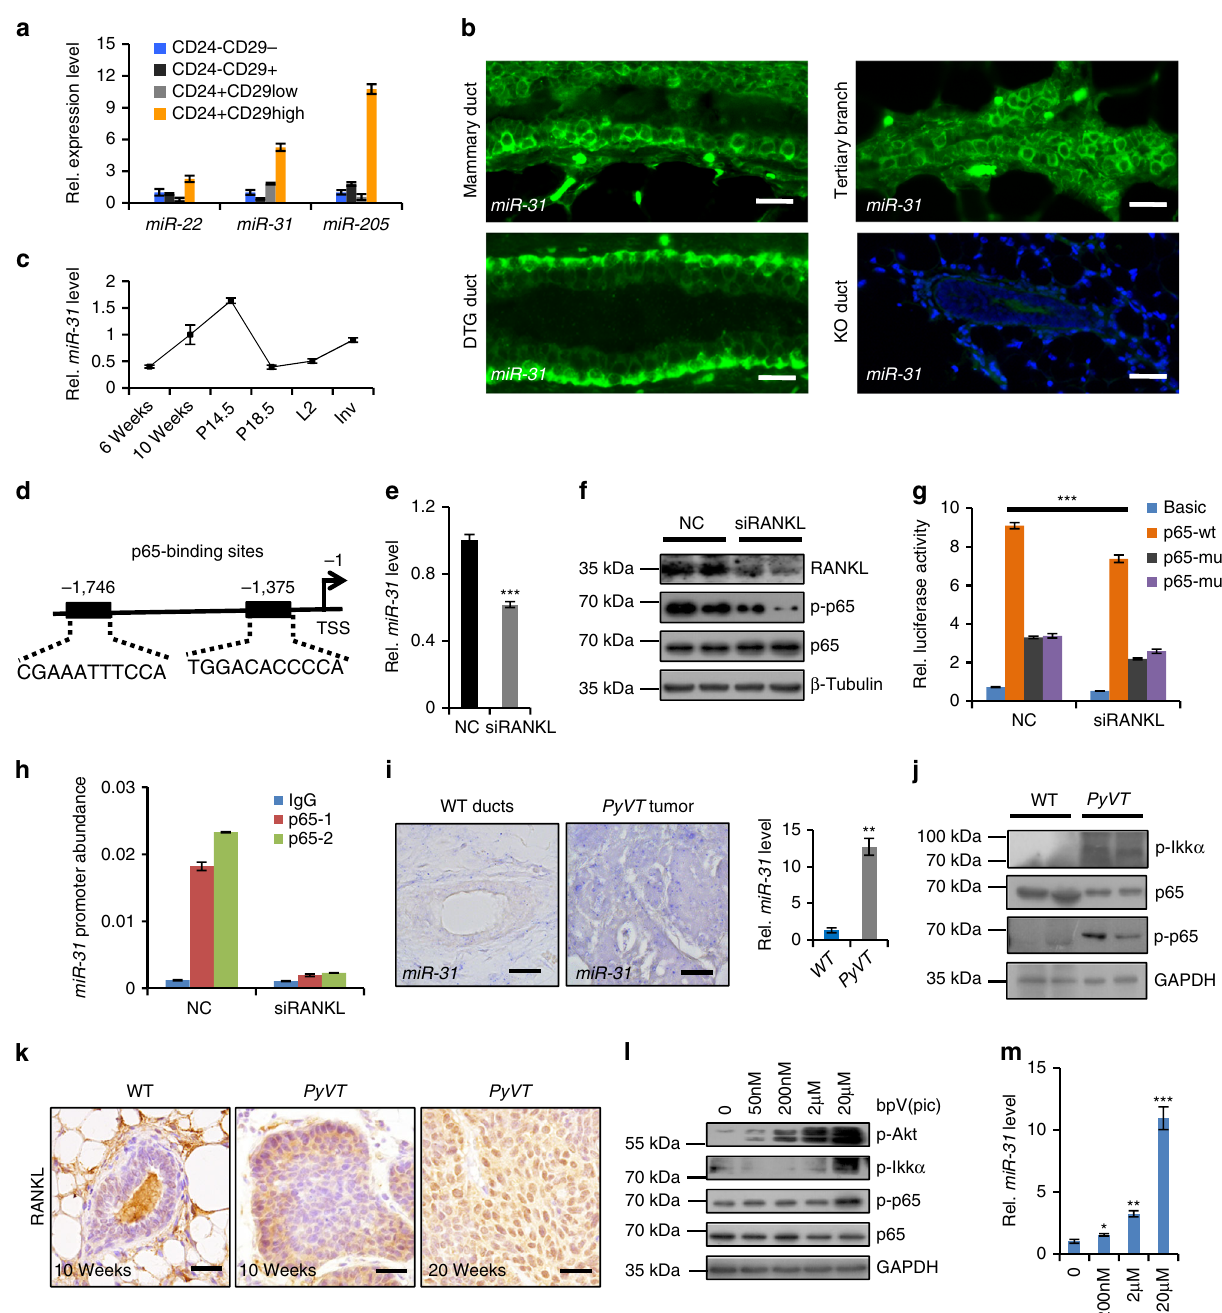
Fig. 1 Expression pattern of miR-31 in mammary gland and tumors. a qRT-PCR for miR-31 , miR-22 and miR205 in Lin - CD24 + CD29 high , Lin - CD24 + CD29 low , Lin - CD24 - CD29 + and Lin - CD24 - CD29 - populations at 12 weeks of age. n = 3 biological replicates. b In situ hybridization for miR-31 in 12-week-old WT mammary gland ducts and tertiary branches. DTG mammary ducts, a positive control. The DTG mice have been administered with Dox at 1 week of age. miR-31 KO mammary ducts, a negative control. Scale bar, 25 μ m. c qRT-PCR for miR-31 in WT mammary epithelial cells at 6, 10 weeks, P14.5 (14.5 days post pregnancy), P18.5, L1 (1 day post lactation) and Inv (10 days post involution). n = 3 at each time points. d The schematic diagram showing two potential p65 (NF- κ B) binding sites (-1746 bp and -1375 bp) in the miR-31 promoter. TSS, transcription start site. e , f qRT-PCR for miR-31 e and western blotting for RANKL, p-p65, p65 f in HC11 mouse mammary epithelial cells treated with RANKL siRNA (SiRANKL), and scramble RNA (NC). g Luciferase activity in lysates of HC11 mouse mammary epithelial cells transfected with luciferase reporter plasmids of pGL3-basic plasmid, miR-31 promoter or miR-31 mutant promoter with mutation at the -1375 (p65-mut-1) or -1746 (p65-mut-2) binding site, treated with scramble RNA (negative control, NC) and RANKL siRNA. h ChIP assays carried out on HC11 mammary epithelial cells using antibodies against p65 under indicated conditions. i – k In situ hybridization and qRT-PCR analysis for miR-31 i and western blotting for p-Ikk α , p-p65 and p65 j , and immunohistochemistry for RANKL k in WT mouse mammary gland and PyVT tumors. Scale bar, 25 μ m. l western blotting for p-Akt, p-Ikk α , p-p65 and p65 in MCF7 breast cancer cells treated with Pten inhibitor bpV(pic) at indicated concentrations for 12 h. m qRT-PCR for miR-31 in MCF7 breast cancer cells treated with PTEN inhibitor bpV(pic) at indicated concentrations for 12 h. Data represented as mean ± S.D. Sample size: WT ( n = 3) and PyVT ( n = 3) for i – k . Two tailed unpaired t -test for e , g , i , m (* P < 0.05; ** P < 0.01; *** P <